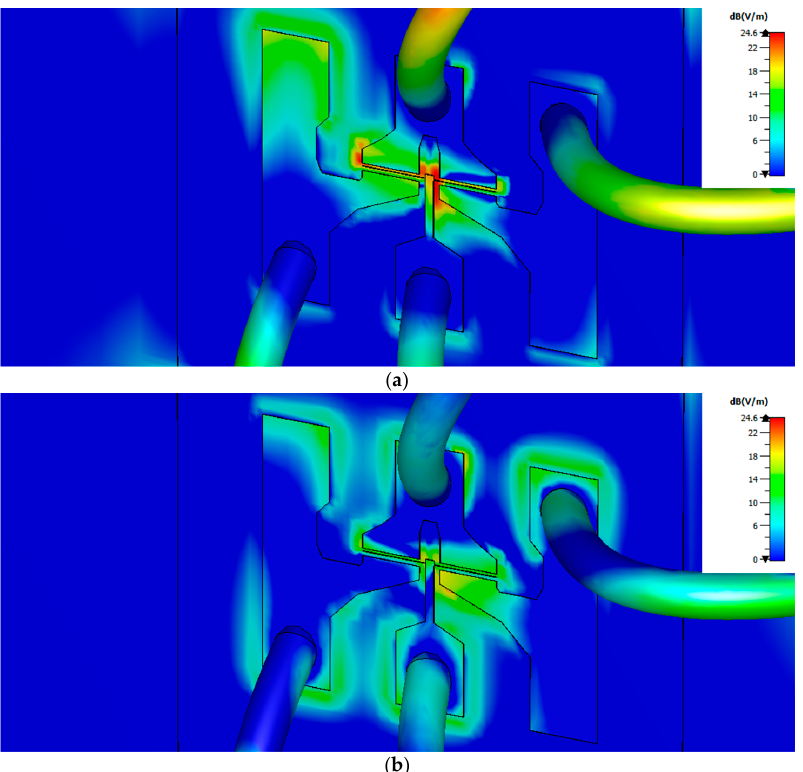
Figure 8. Spatial distributions of the module of the normalized electric field inside the transistor channel under illumination at 0.15 THz, ( a ), and 0.30 THz, ( b ), when the four 0.25 µ m long bonding wires were included in simulations. The maximum values of the normalized electric field inside the channel are 35.64 dB and 25.49 dB for excitation at 0.15 and 0.30 THz, respectively, as displayed on Tables 3 and 4. Black solid lines indicate the contour of the top side transistor electrodes and are a guide to the eye.